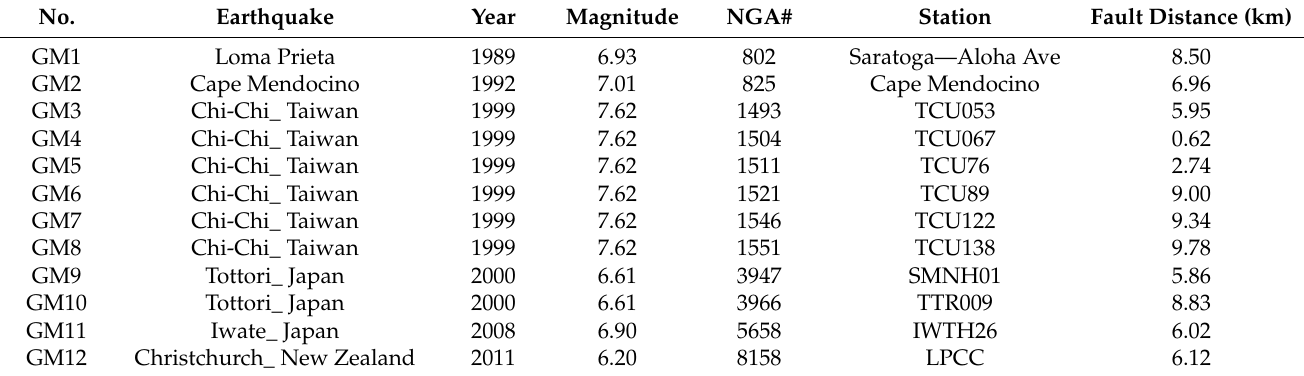
Table 3. Earthquake